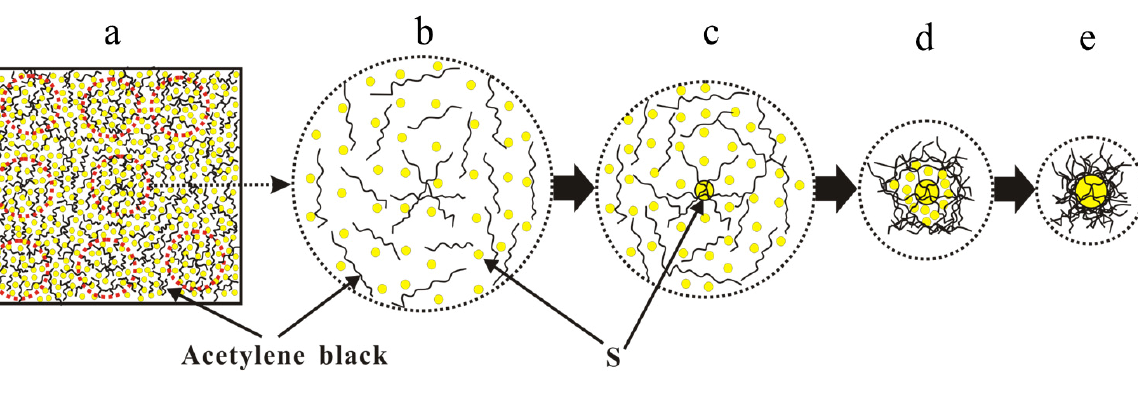
in the CS solution 8 2